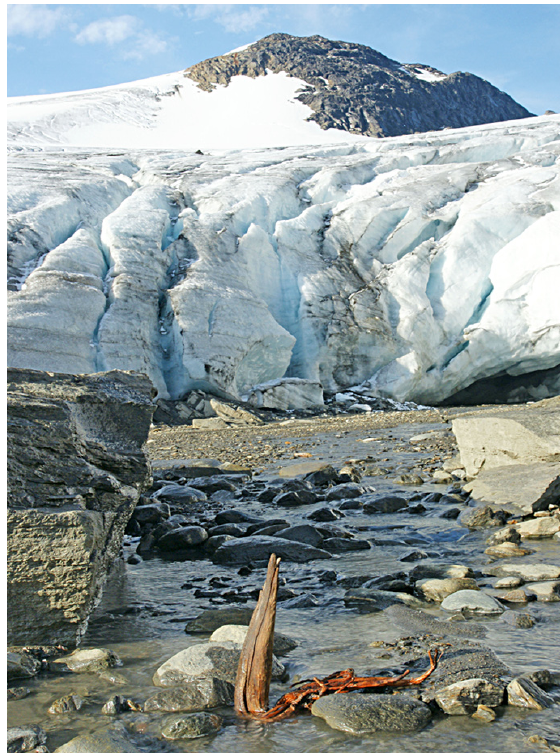
Figure 38: Kårsajökeln (8). Piece of a subfossil pine (upraised), unearthed from water-eroded outwash material. 11760 cal. yr BP (Beta-250906).